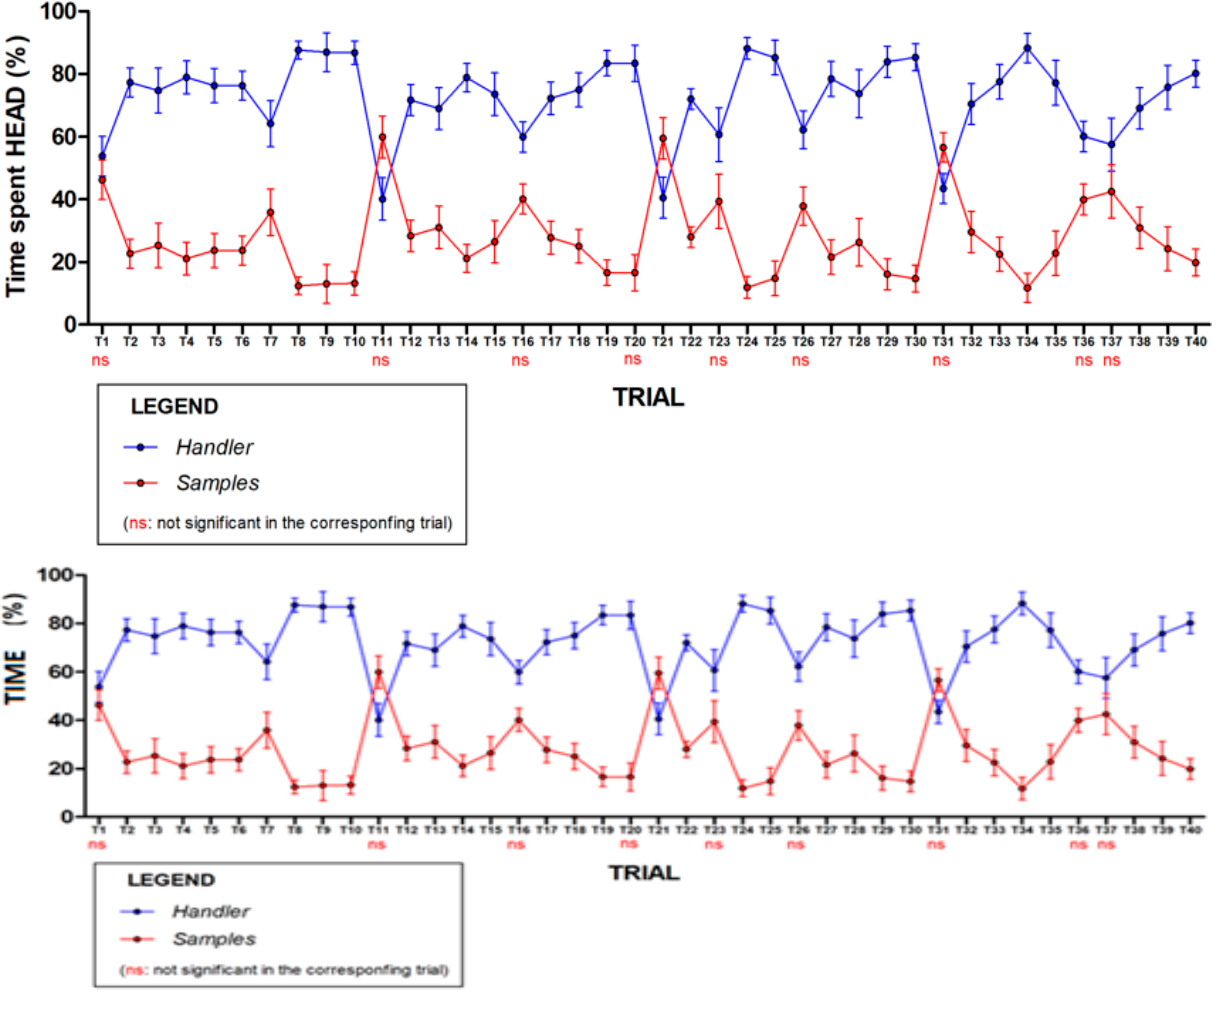
Figure 2. Percentage of time spent by the dog with its head within handler vs. sample areas. Percentage of time spent by the dog with its head within the handler vs. the samples area in each trial. Differences were statistically significant in all trials, except for trials 1, 11, 16, 20, 23, 26, 31, 36, and 37, in which the difference between time spent with handler vs. time spent with samples was not significant.